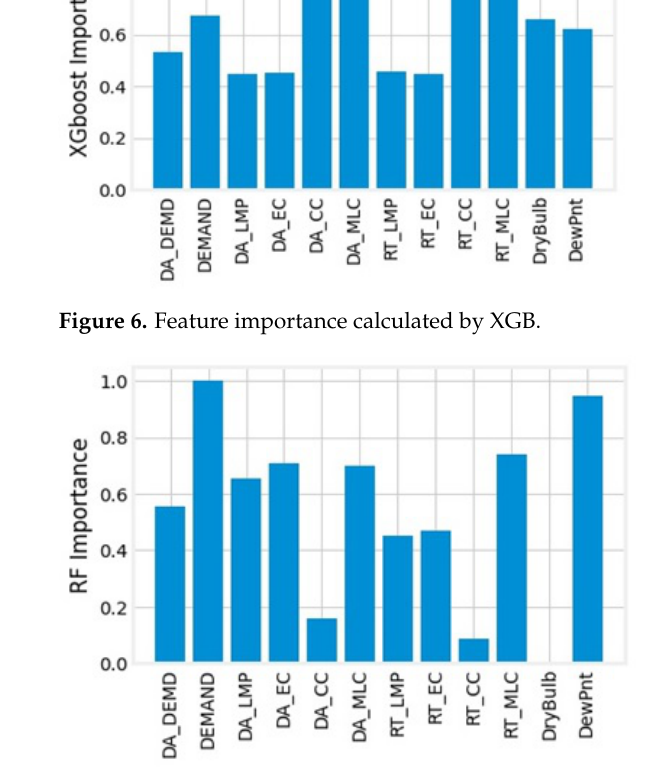
Figure 7. Feature importance calculated by RF.